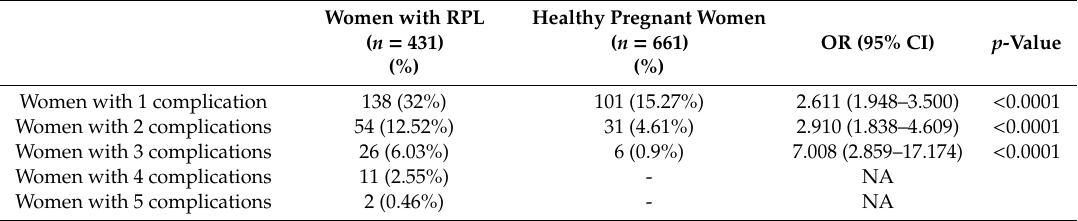
Table 5. Number of concomitant pregnancy complications in study